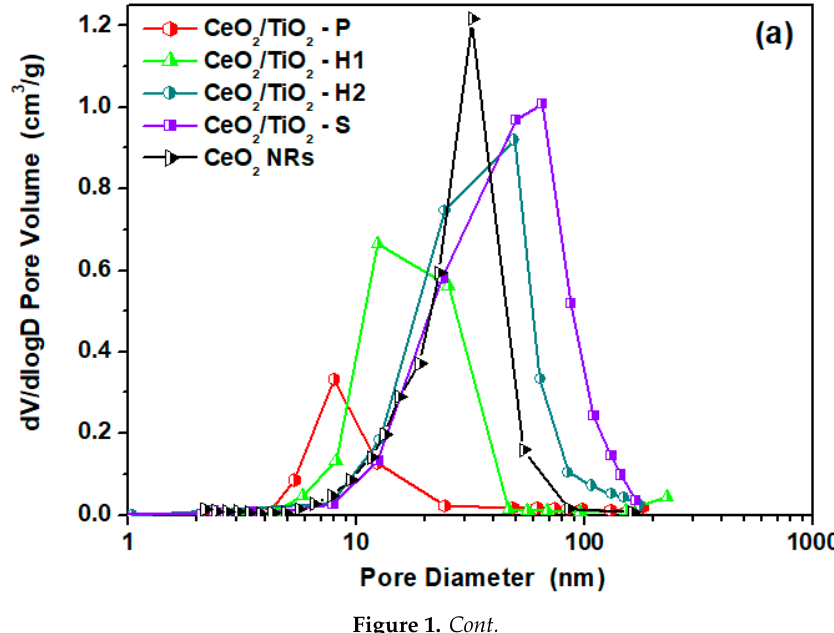
Table 1. Textural / structural, redox properties of CeO 2 and CeO 2 / TiO 2 samples.